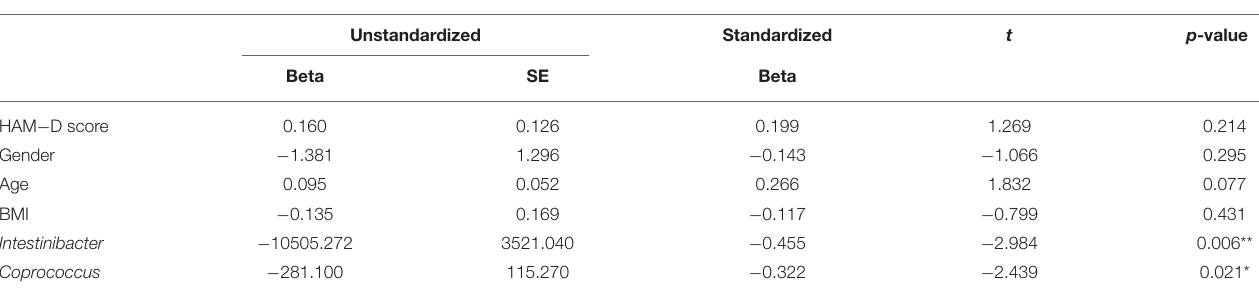
TABLE 4 | Linear regression analysis results for PSQI at the genus